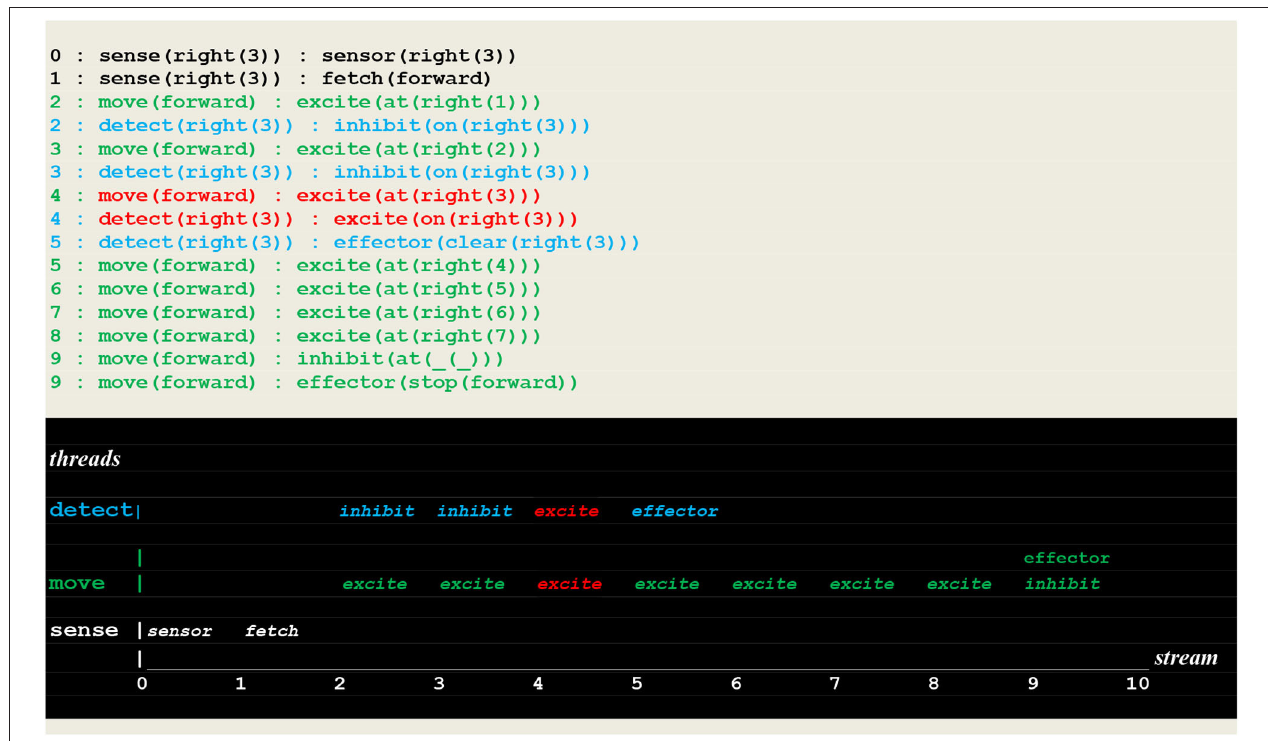
FIGURE 11 | Execution trace of the vehicle randomly moving into the correct direction. Following a correct fetch(forward) random choice, two simultaneous excite internal stimuli indicate that two synchronized perceptions occurred, namely the detection of a fire at the vehicle’s position. Subsequently the fire was